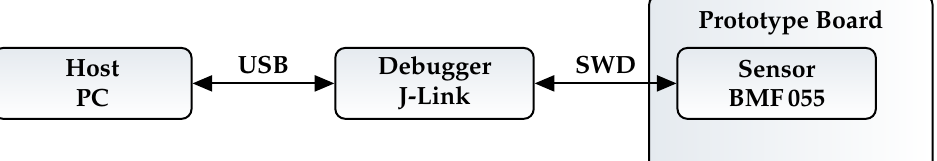
Figure 4. Physical connections used on the